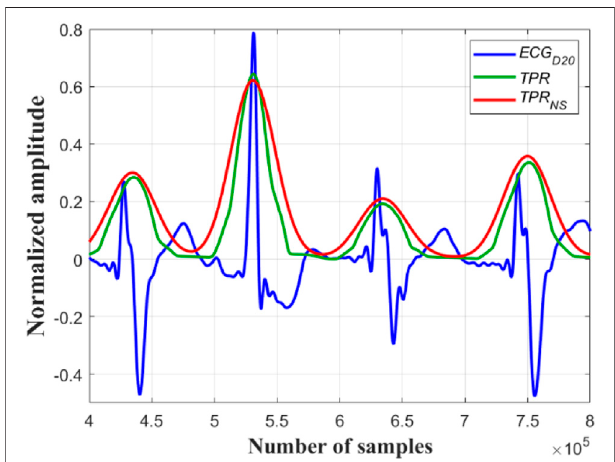
Frontiers in Signal Processing |